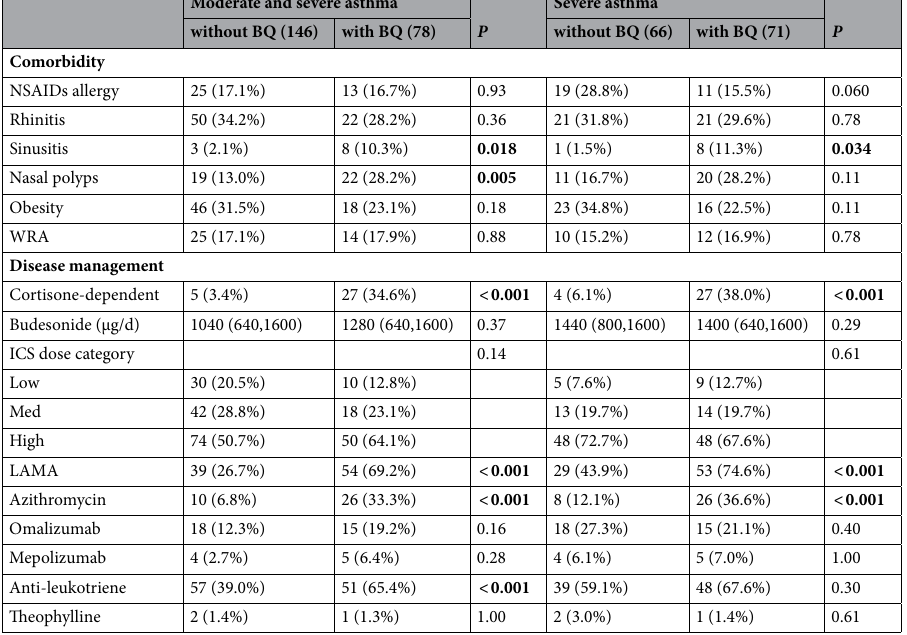
Table 2. Comorbidities and disease management of the study population. Continuous variables expressed as mean (SD) or median (p25, p75); categorical data expressed as percentage n (%); BQ: non-cystic fibrosis bronchiectasis; NSAIDs, allergy to nonsteroidal anti-inflammatory drugs; LAMA: long-acting muscarinic receptor antagonists; ICS: Inhaled Corticosteroid. Significant p values in bold font.